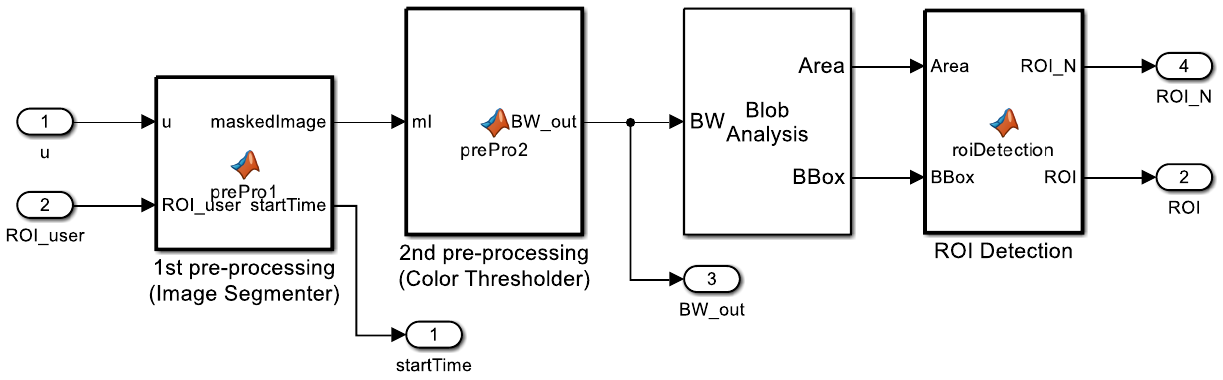
Figure 3. An ROI detection block in digit